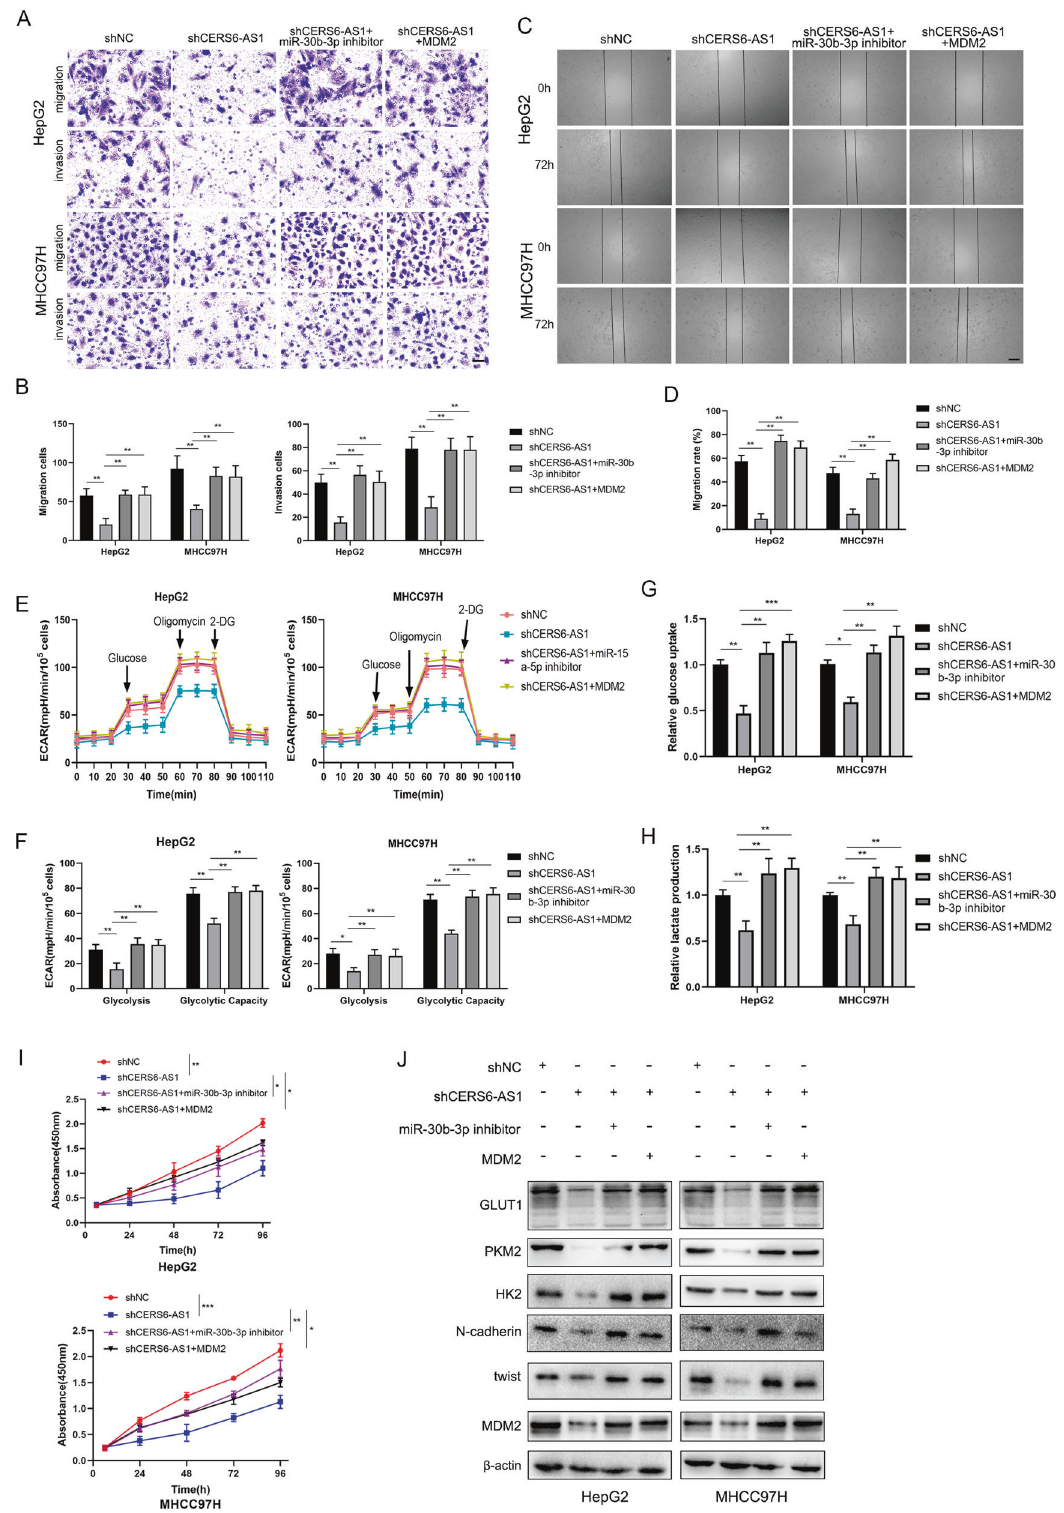
Fig. 6 LncRNA CERS6-AS1 facilitates HCC progression via modulating MDM2 expression. A – D MDM2 overexpression or miR-30b-3p inhibitors partly reversed the inhibition effect of CERS6-AS1 knockdown on migration and invasion of HepG2 and MHCC97H. Transwell assay, Scale bar: 100 μ m; Wound healing assay, Scale bar: 250 μ m. E – H MDM2 overexpression or miR-30b-3p inhibitors partly reversed the inhibition effect of CERS6-AS1 knockdown on aerobic glycolysis of HepG2 and MHCC97H. I MDM2 overexpression or miR-30b-3p inhibitors partly reversed the inhibition effect of CERS6-AS1 knockdown on proliferation of HepG2 and MHCC97H. J MDM2 overexpression or miR-30b-3p inhibitors partly reversed the inhibition effect of CERS6-AS1 knockdown on protein expression involved in EMT (N-cadherin, twist) and glycolysis (PKM2, GLUT1). * p < 0.05, ** p < 0.01.